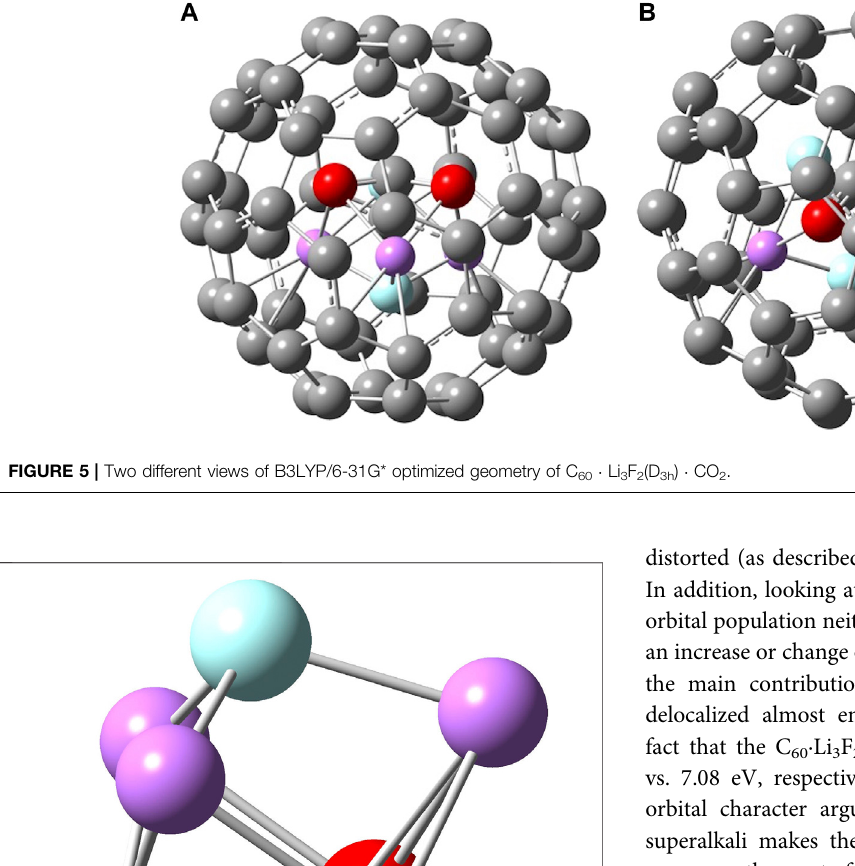
Frontiers in Chemistry |